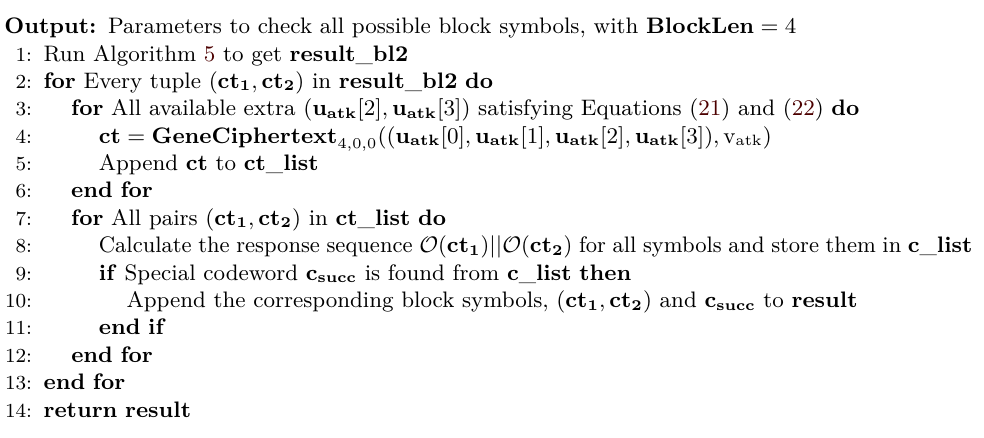
Algorithm 6 Generating proper ciphertexts for “Checking” when BlockLen =